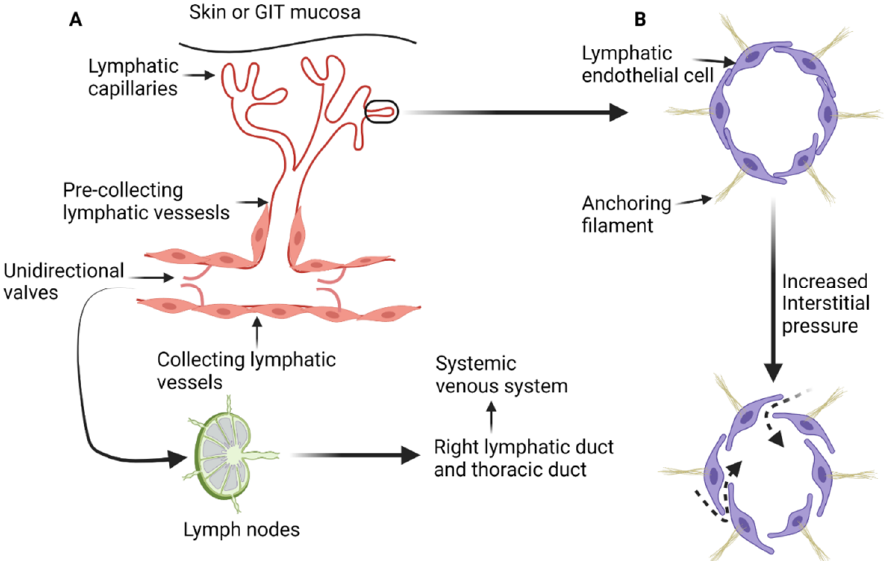
Figure 1. Diagrammatic illustration of the anatomy and physiology of the lymphatic system. ( A ) The blind end lymphatic capillaries that drain in the pre-collecting lymphatic vessels. Lymph is then transferred to the collecting lymphatic vessels and get filtered by the lymph nodes. All lymph from the human body ends in the systemic venous system through either the thoracic duct or right lymphatic duct. ( B ) The effect on increased interstitial pressure on the loose junctions between lymphatic endothelial cells, leading to increased transmission of the interstitial fluid and proteins to the lymphatic capillaries and pre-collecting lymphatic vessels (dashed arrows). “Created